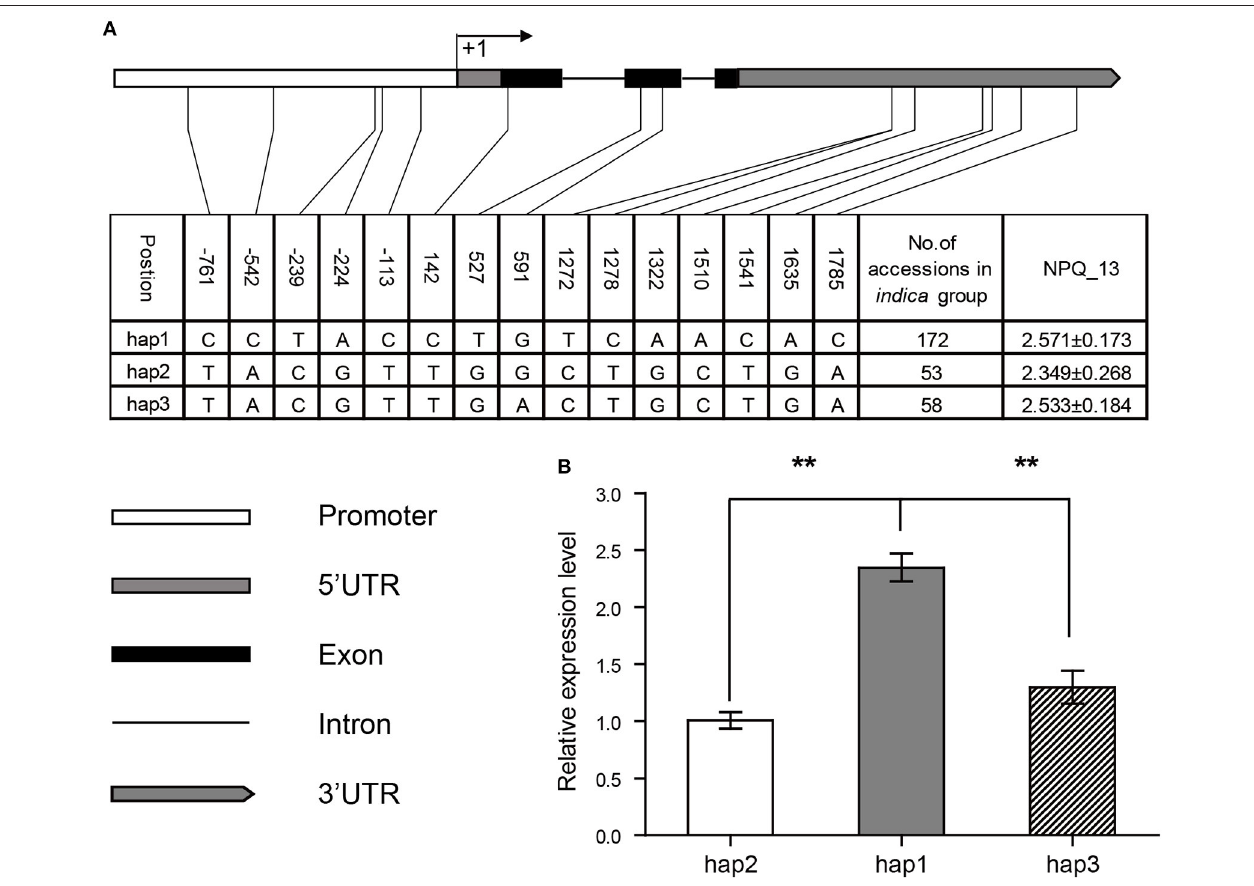
FIGURE 5 | Haplotypes (A) and expression levels (B) of the candidate gene (LOC_Os01g01340) in indica group. Three major haplotypes were detected, and the number of accessions in each haplotype is shown. The positions of SNPs are shown in the first row. Trait value (NPQ_13) is indicated in the right column. Graphical representations of the gene structure and expression levels of the gene in different haplotypes are shown below. **Indicates the differences of expression levels between hap1 and hap2 or hap3 are significant at P <